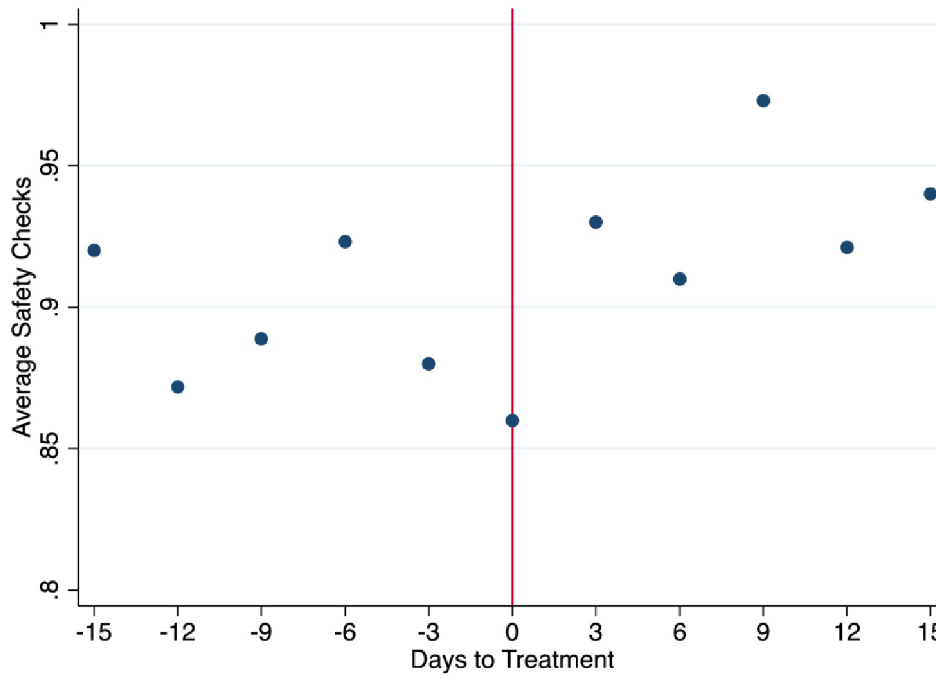
Fig 4. Before and after averages of safety